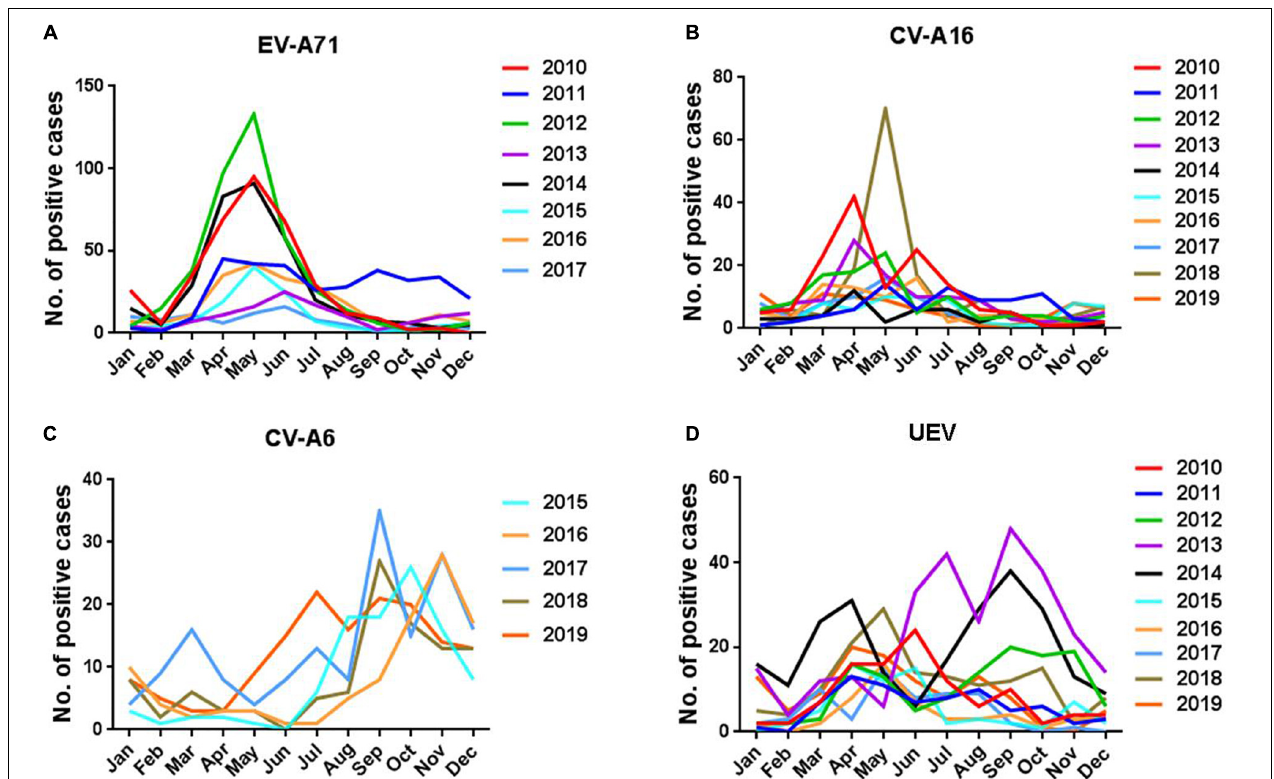
FIGURE 7 | Seasonal features of enterovirus by serotypes. (A) EV-A71; (B) CV-A16; (C) CV-A6; (D)